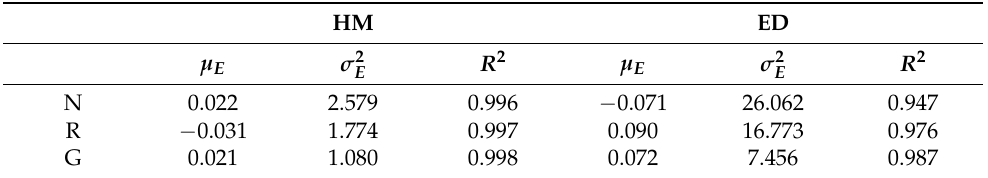
Table 4. Error characteristics of NRG self-validation tests with ( α , λ ) = ( 500,8 ) ; mean of intensity differences, variance of intensity differences, and coefficient of determination.